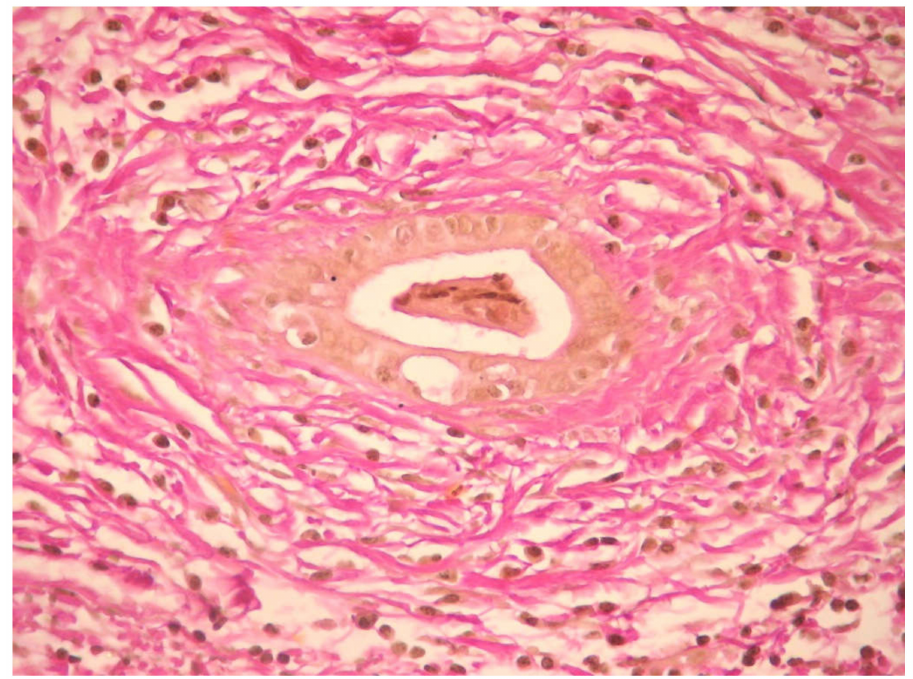
Figure 4. Periductal fibrosis—Van Gieson coloration 400 ×